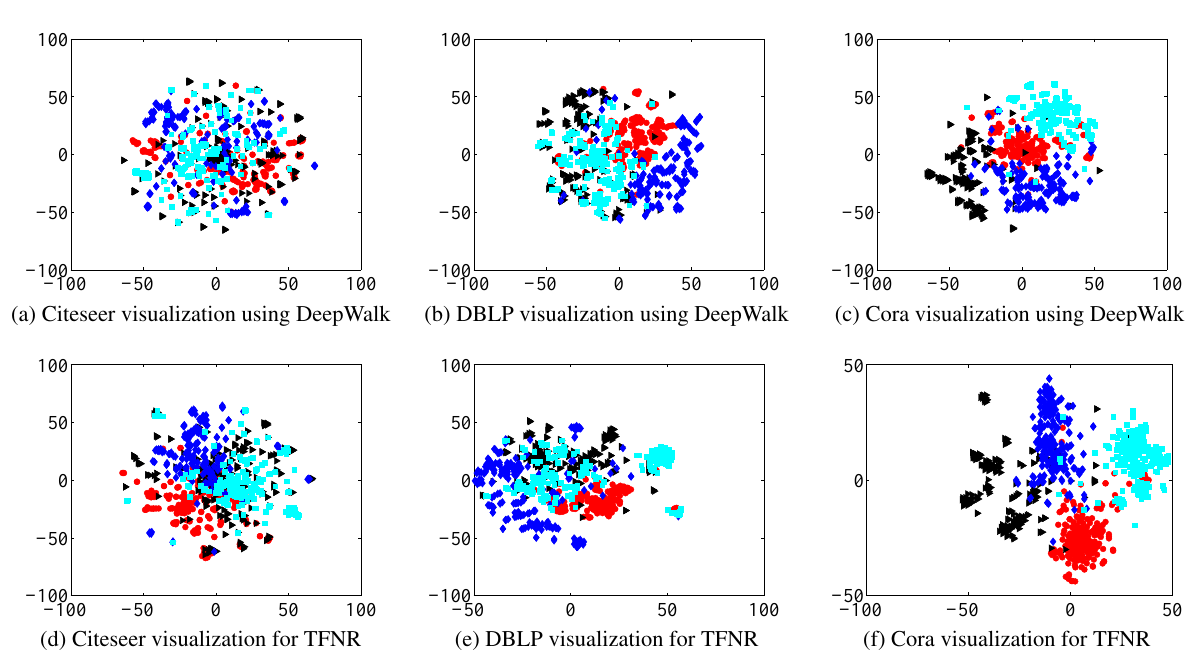
Fig. 5 2D visualization on Citeseer, DBLP, and Cora datasets. The abscissa and ordinate values are the two-dimensional coordinate values of the t-SNE algorithm after dimensionality reduction, in which different colors represent different types of nodes.